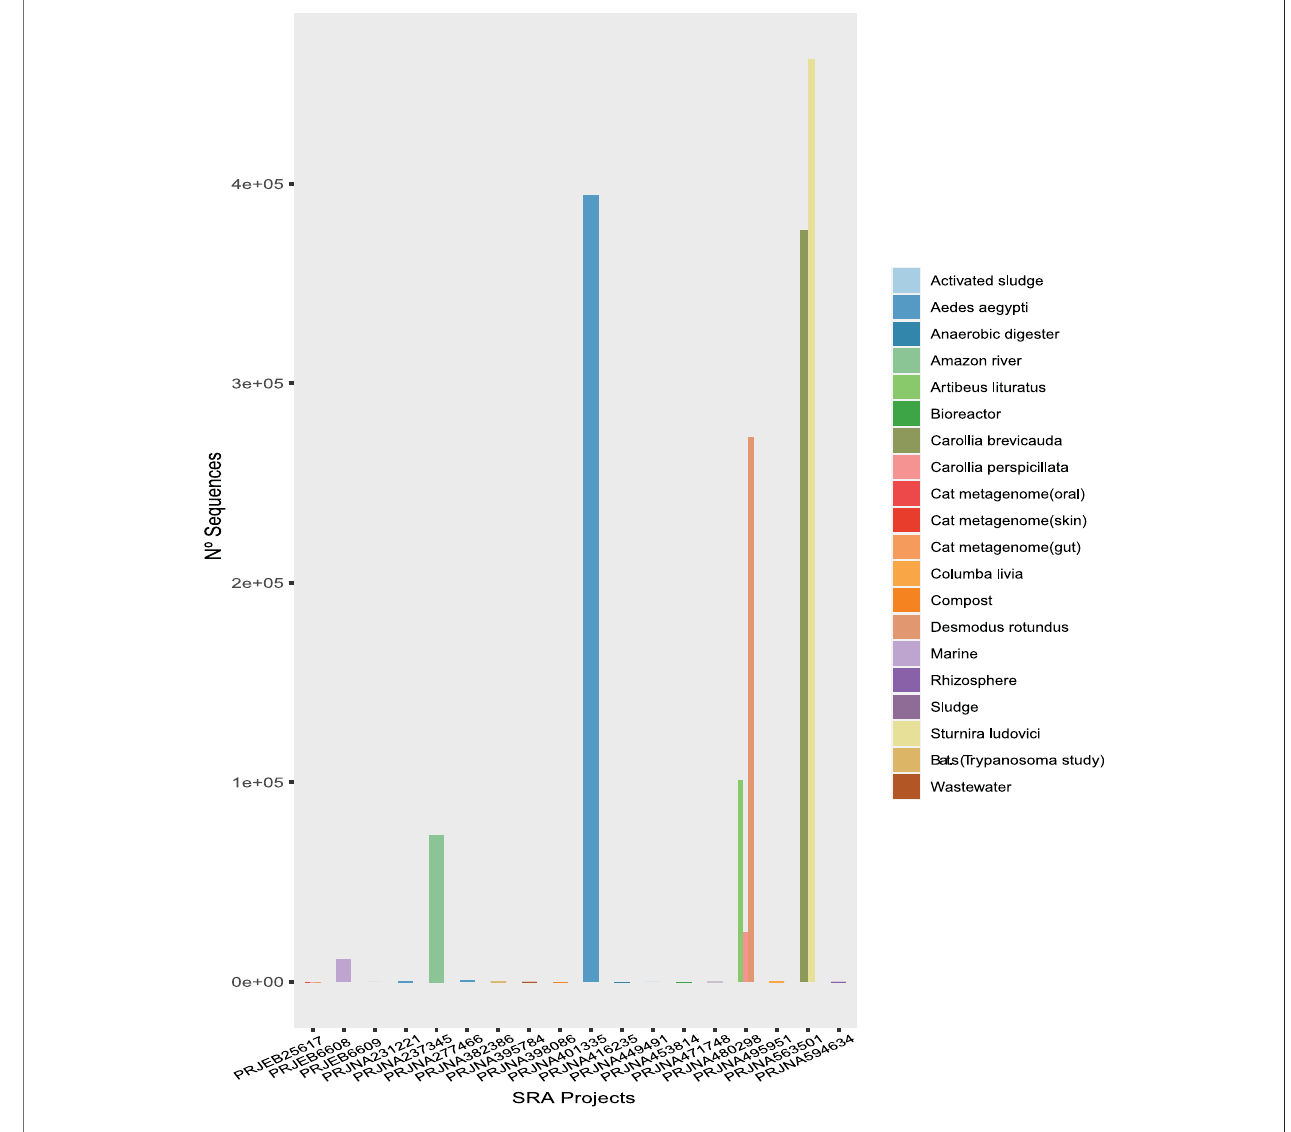
FIGURE 1 | The number of sequences of probable viral origin identi fi ed in each metagenome analyzed.